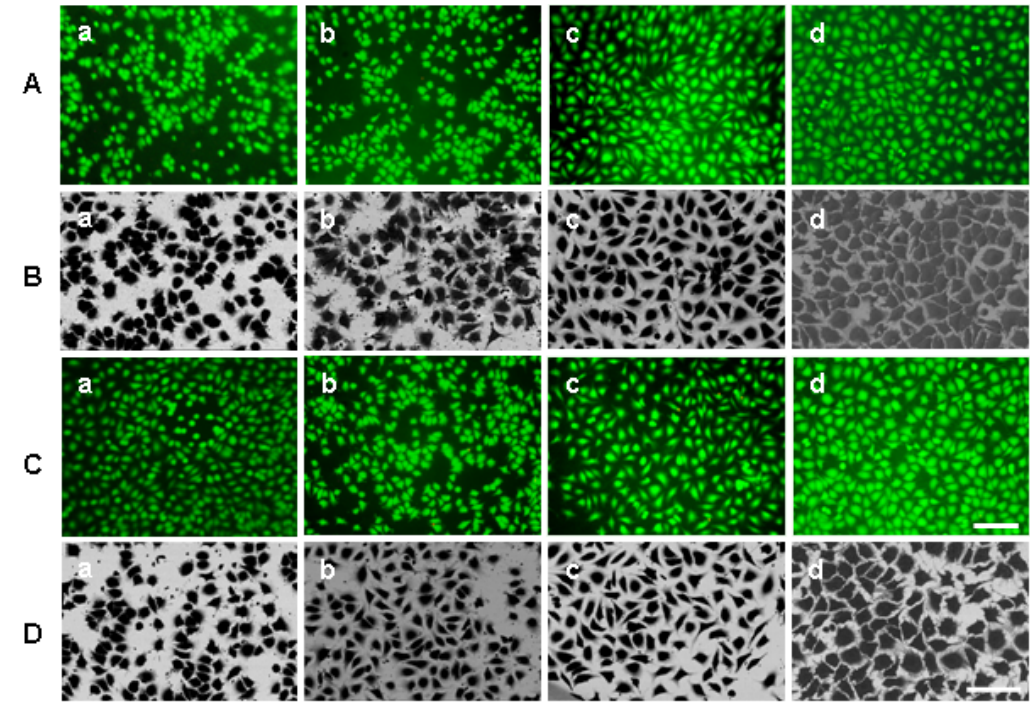
Figure 3. Representative inverted fluorescence (rows A and C) and BSE-microscopic images (rows B and D) of L929 cells after cultivation on the PE-surface. The cells were cultured for 2 (a), 4 (b), 8 (c) and 24 (d) hours on PE-surface treated with argon-plasma (A and B) or oxygen-plasma (C and D). Scale bars: 100 μ